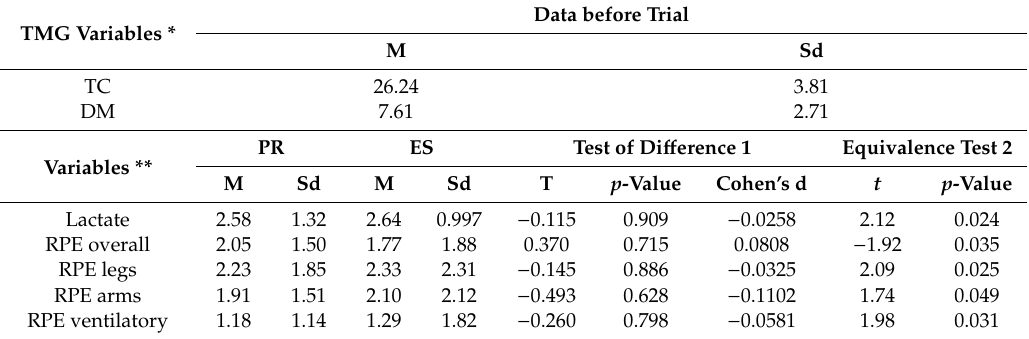
Table 1. Description of tensiomyography (TMG) variables before the trial, and comparison before a water rescue of baseline levels of blood lactate and perceived exertion between recovery types. TMG Variables